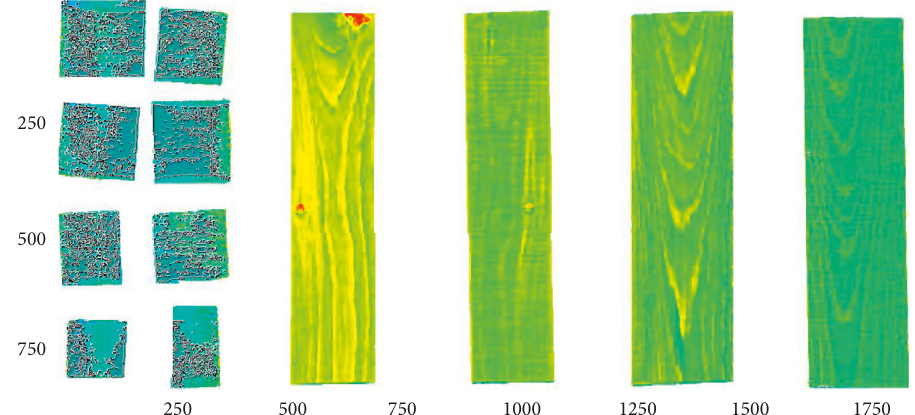
Figure 5: Contour 2D image of PC2 related to the area representing data from naturally seasoned and kiln-dried wooden surfaces indicated by red arrows in Figure 4(a).